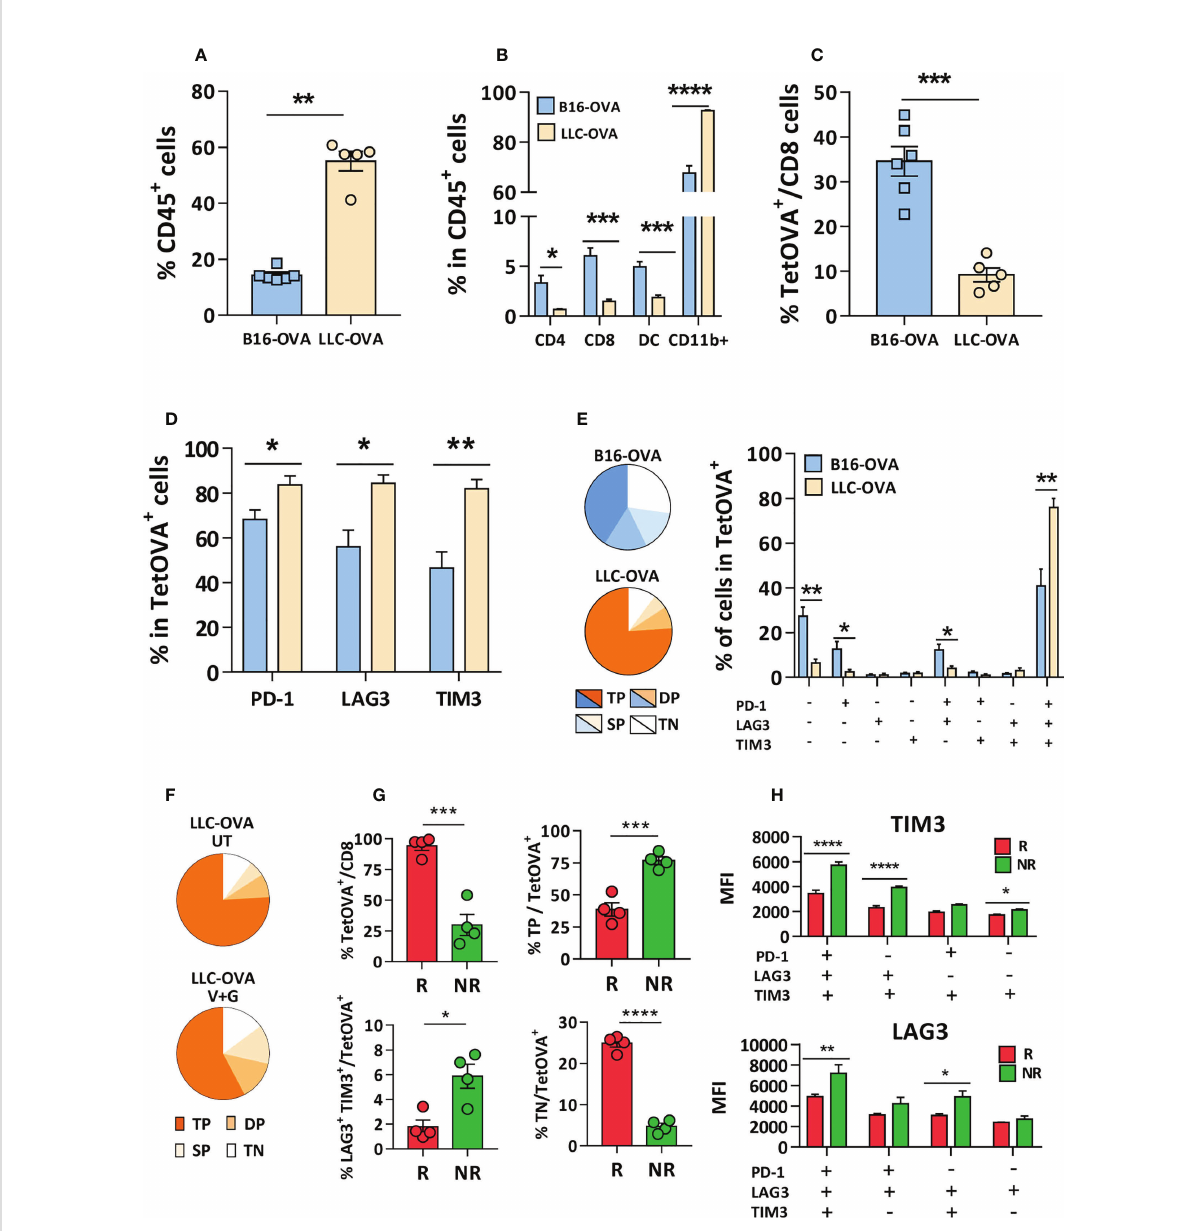
FIGURE 6 CD8 T-cells in non-responder mice to combinations with anti-PD-1 display an exhausted phenotype with multiple inhibitory receptors. Five mm LLC-OVA or B16-OVA tumors (n=5-6/group) were obtained from untreated C57BL/6J mice and fl ow cytometry was used to determine (A) the CD45 + leukocytic in fi ltrate, (B) the proportion of CD4, CD8, DC and myeloid CD11b + cells and (C) TetOVA + cells in CD8 cells. In the case of TetOVA + cells, the proportion of cells expressing PD-1, LAG3 or TIM3 (D) and the combined expression of these markers is shown grouped as pie chart (triple negative, TN; single positive, SP; double positive, DP; triple positive, TP) or in individual bars (E) . Mice with LLC-OVA tumors (n=8/group) were treated for one week with vaccine + gemcitabine (V+G) or left untreated (UT) and the proportion of TN, SP, DP and TP TetOVA + cells was determined by fl ow cytometry (F) . Percentage of TetOVA + cells, TP, DP (LAG3 + TIM3 + ) and TN cells in mice responding (R) or not (NR) (n=4/group) to vaccine + gemcitabine treatment after one week (G) and the fl uorescence intensity (H) of LAG3 and TIM3 in TetOVA + cells positive for these markers. Bars show mean + SEM (*, P<0.05; **, P < 0.01; ***, P < 0.001; ****, P <